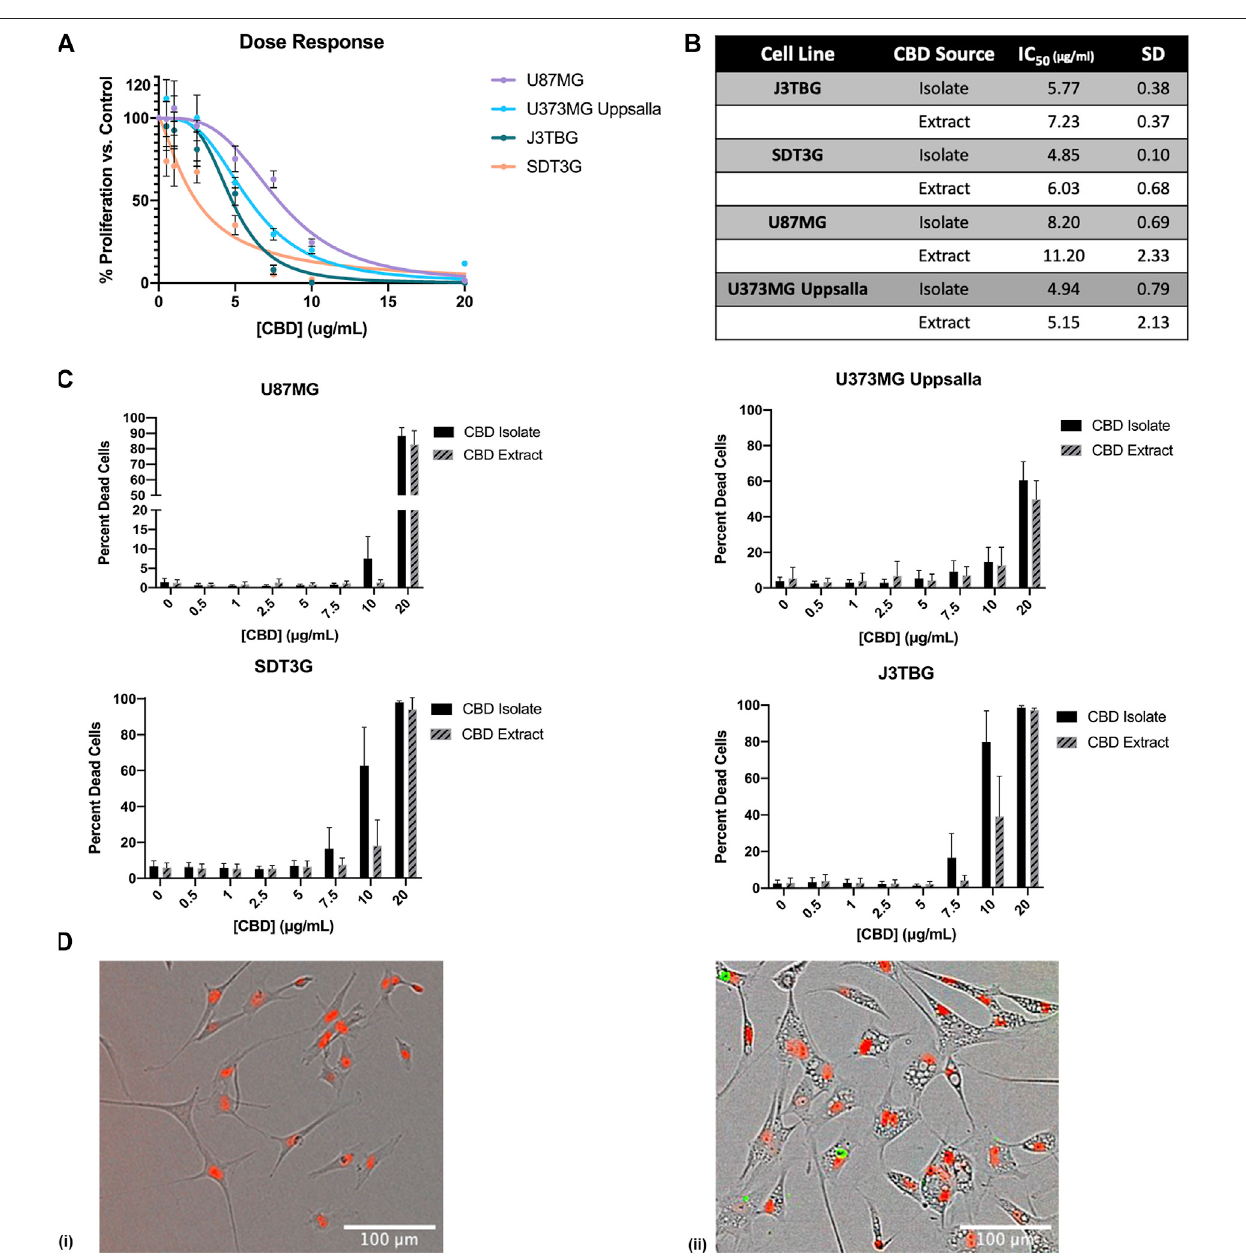
FIGURE 1 | CBD is antiproliferative and cytotoxic to glioma cell lines. (A) U87MG, U373MG, J3TBG, and SDT3G Glioma cells were treated with CBD isolate (0 – 20 μ g/ml) for 96 h. Cell proliferation and dose response were measured via IncuCyte ™ Red Object Count. Data are from n (cid:1) 4 independent repeated experiments. Individual points expressed as mean ± SD, curve fi t through a non-linear, variable slope regression (B) IC 50 values were determined from the curve fi ts via GraphPad PrismforbothCBDisolateandextractat96 h.Dataarefrom n (cid:1) 4independentlyrepeatedexperiments (C) U87MG, U373,J3TBG,andSDT3GGliomacellswere treated with CBD isolate or extract (0 – 20 μ g/ml) for 96 h. Cytotoxicity was determined using the green fl uorescent dye, YOYO-1. Data are from n (cid:1) 4 independently repeated experiments , expressed as mean ± SD (D) SDT3G glioma cells treated with 0 μ g/ml CBD after 48 h (i), SDT3G Glioma cells featuring formation of intracellular vesicles after 48 h oftreatmentwith 7.5 μ g/ml CBD isolate (ii) At 48 h, cell death isnot occurring at this concentration. Red fl uorescence represents nuclei ofviable cells. Images were captured through a 10x Nikon objective.